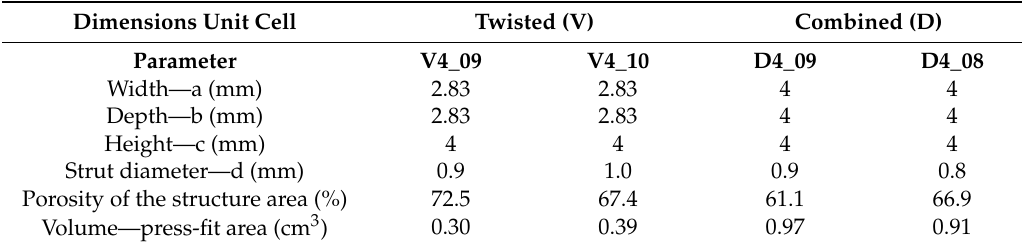
Table 1. Listing of the various cup designs based on the unit cell variants of the two investigated designs (twisted and combined) as well as of the unit cell dimensions, porosity, and volume of the press-fit area. The values listed were taken from the CAD data.